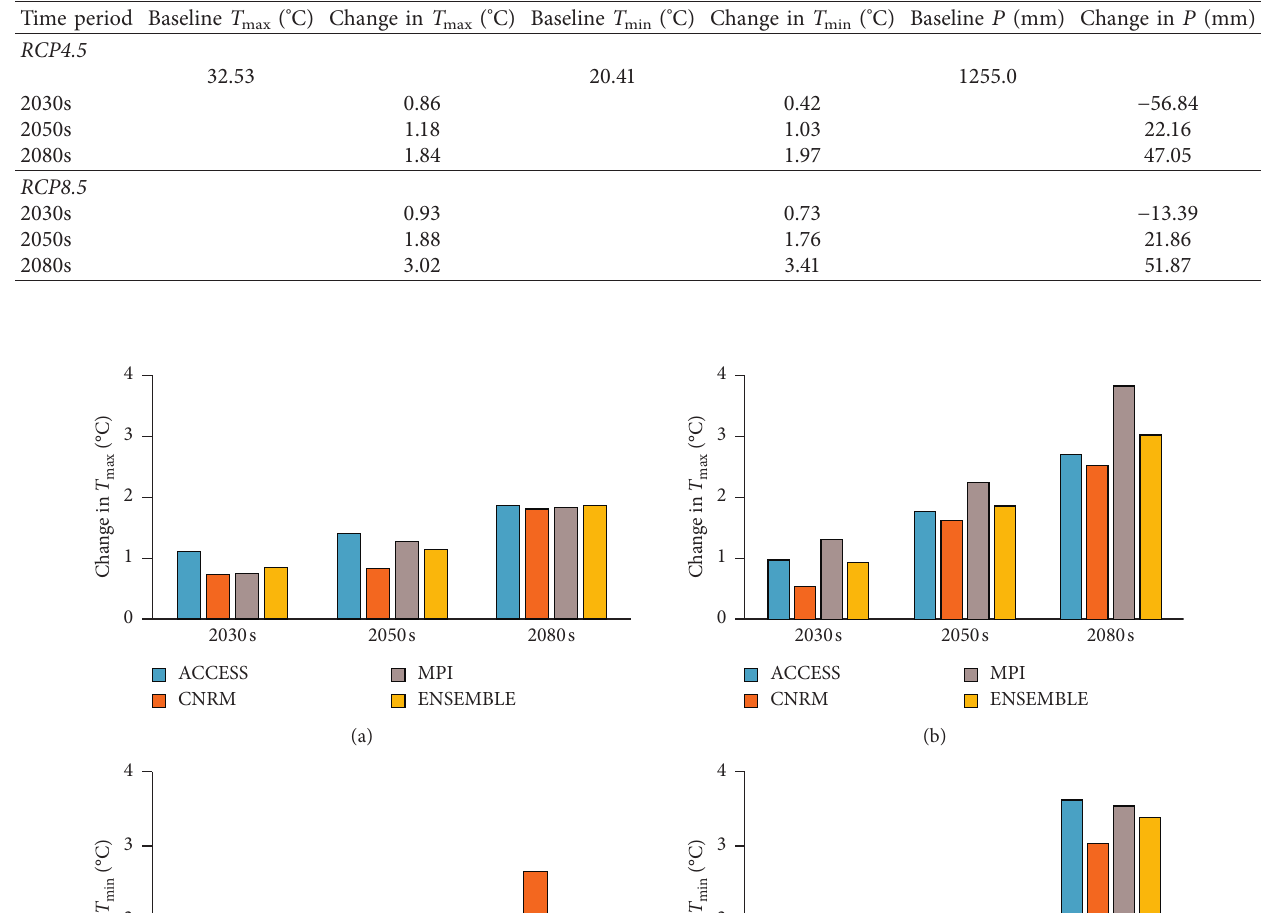
Table 4: Projected changes in annual average ensemble maximum temperature ( T